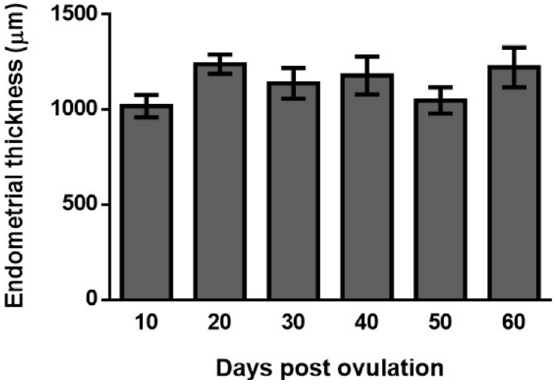
Figure 1 - Mean and standard error of the endometrial thickness (μm) of the uterine horns in bitches of different groups: 10 (n=10); 20 (n=8); 30 (n=8); 40 (n=8); 50 (n=6); and 60 (n=10) days post ovulation, p>0.05.